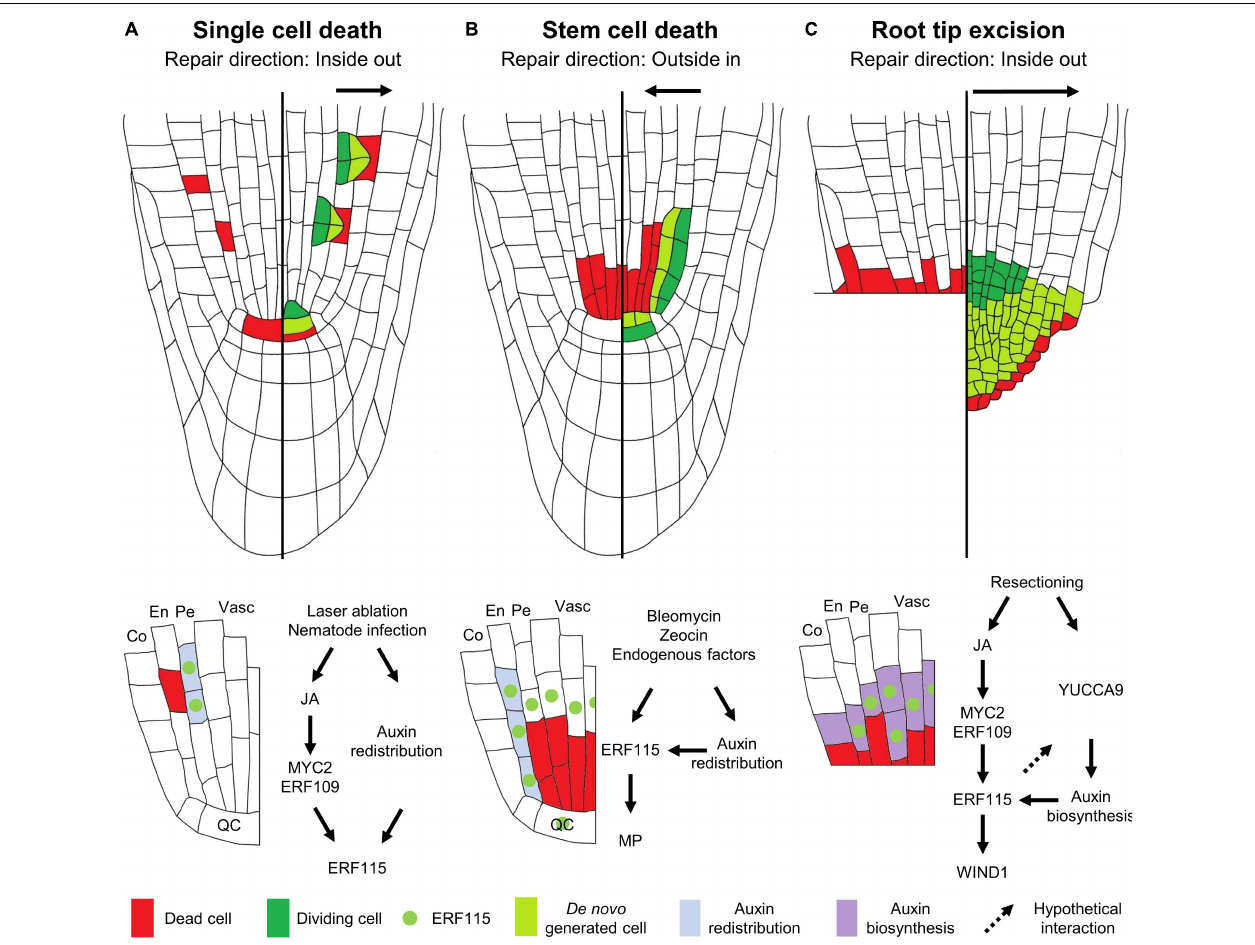
FIGURE 1 | Modes of regeneration in the Arabidopsis root apical meristem following (A) single cell death, (B) vascular stem cell death, or (C) root tip excision. The left sides of the roots show the type of damage inflicted, the right sides illustrate the regenerative response, and the schemes below the roots indicate the molecular response. (A) Upon single cell damage, activated JA signaling results in the induction of the ERF115 transcription factor (green dot) in cells neighboring the dead cell, via the action of MYC2/ERF109. In parallel, a local auxin response is activated in these cells (light blue). The co-occurrence of ERF115 and activated auxin signaling stimulates these cells to engage into regenerative divisions in order to replace the outward located cell. (B) Vascular stem cell death results in the transcriptional activation of ERF115 in the surrounding cells, including endodermal cells and QC cells. Due to the stem cell death, the perturbed auxin flow results in the establishment of a new auxin maximum in the neighboring endodermal cells, triggering regenerative cell divisions in cells expressing ERF115 and downstream target gene MP , thereby replacing the inward located cells. (C) Loss of the root tip, including stem cells, results in activated JA signaling that, via the action of MYC2/ERF109, triggers ERF115 expression in the vascular and endodermal cells in close contact to the wound site. YUCCA9-mediated auxin biosynthesis at the wound site ensures ample auxin levels required for enforcing ERF115-mediated regenerative divisions. WIND1, directly downstream of ERF115, facilitates root